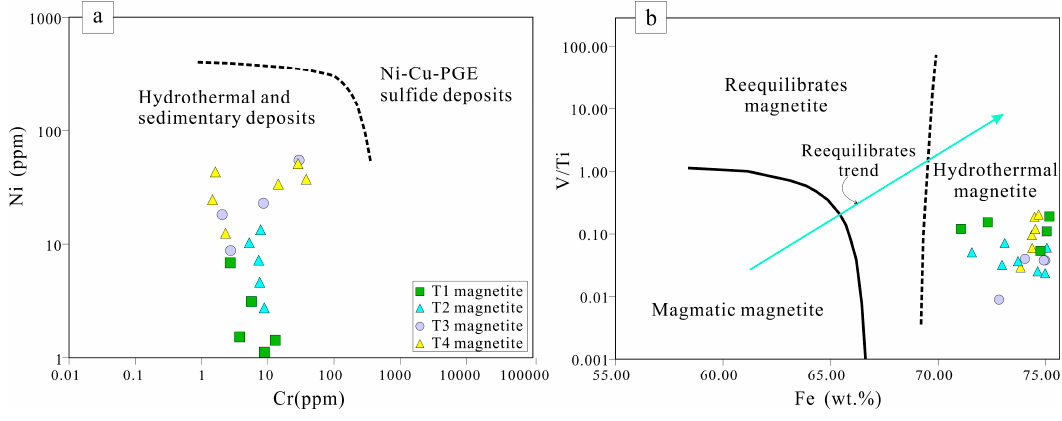
Figure 7. Binary diagrams of ( a ) Ni vs. Cr (after Reference [30]).and ( b ) V/Ti vs. Fe (after Reference [42]) for the Huanggangliang magnetite from the different ore types.